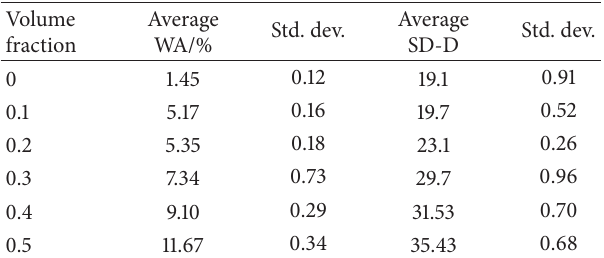
Table 3: Water absorption (WA) and hardness (SD-D) data and their standard deviation (std.